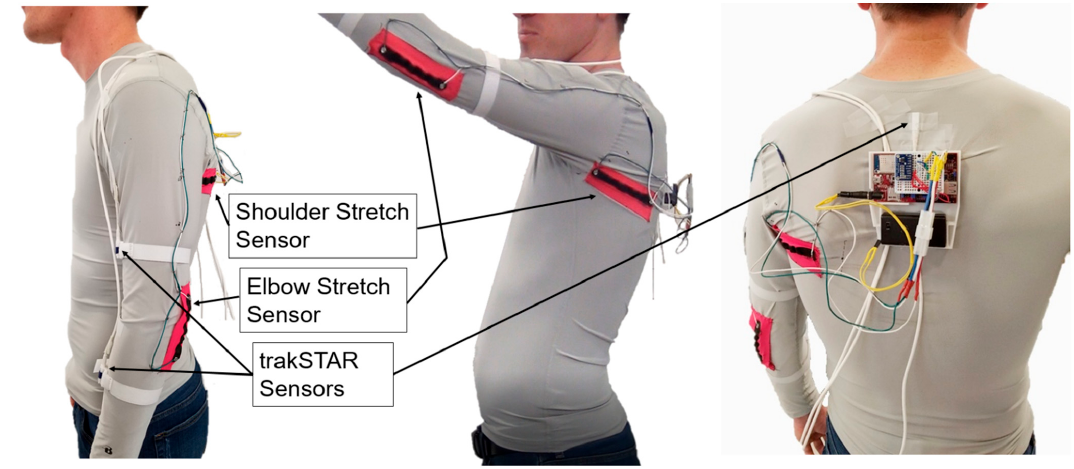
Figure 3. Sensor placements .